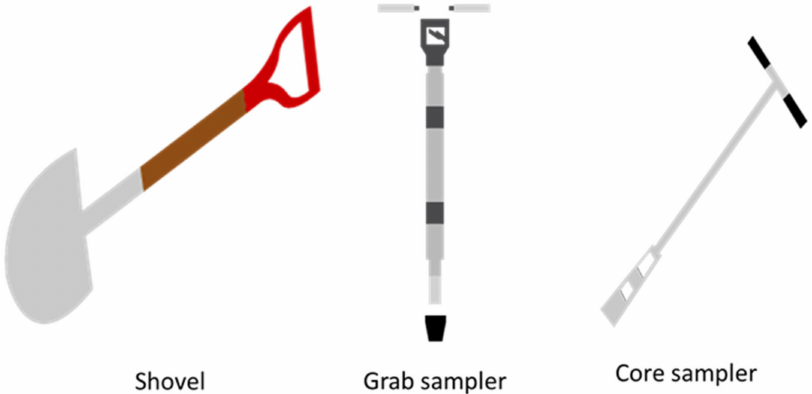
Figure 6. Types of microplastic sampling device for